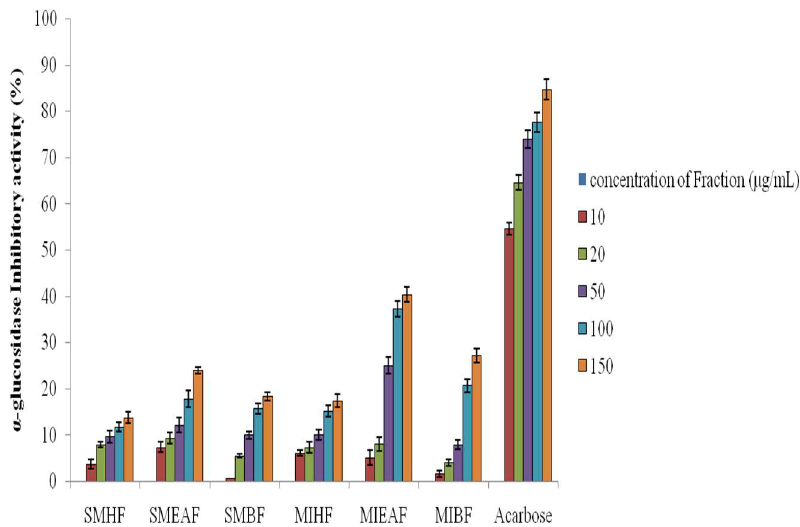
Figure 2. Alpha-glucosidase inhibitory activities of fractions of S. mombin and M. indica leaves . Legends: